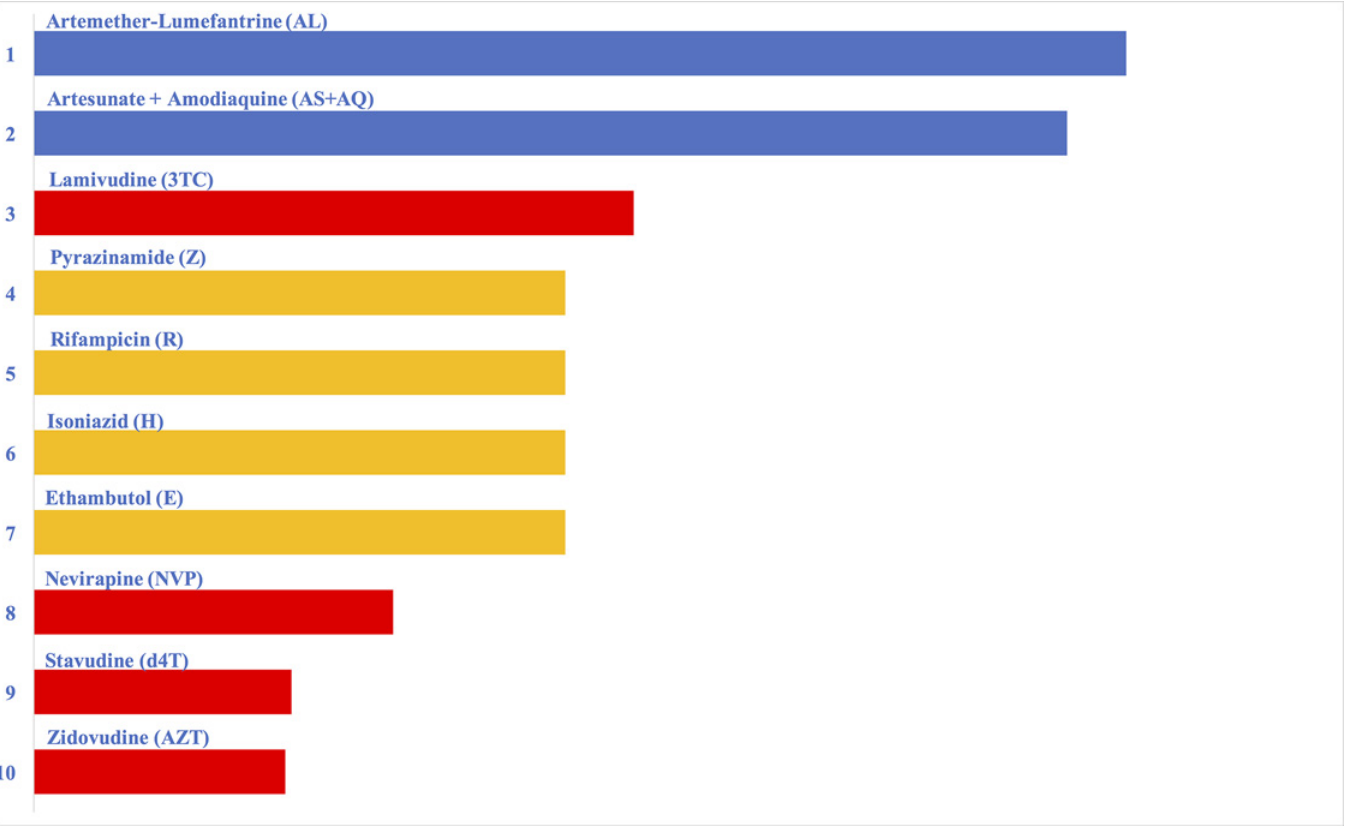
Fig 1. Impact scores of individual drugs by rank. A graph of the comparative impact of the top 10 drugs ranked from 1 (highest impact) to 10 (lowest impact). Blue bars represent malaria drugs, yellow bars represent TB drugs, and red bars represent HIV